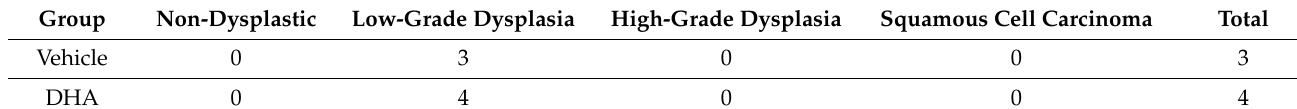
Table 3. Final histology of the cervicovaginal tract after MmuPV1 infection following the treatment period. All mice developed low-grade dysplasia.